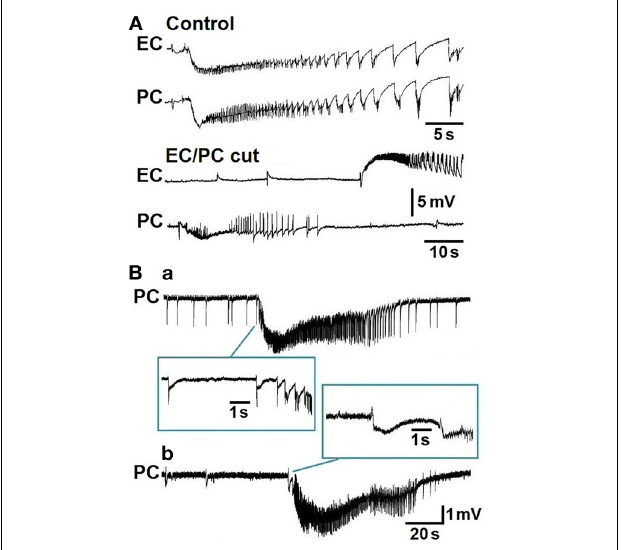
FIGURE 3 | (A) Ictal discharges occur synchronously in entorhinal (EC) and perirhinal (PC) cortices in an in vitro brain slice treated with 4-aminopyridine (Control panel). Note that cutting the connections between entorhinal and perirhinal areas causes the occurrence of independent ictal activity in these two structures (EC/PC cut panel). (B) Two types of ictal discharge initiation can be recorded from the perirhinal cortex during bath application of 4-aminopyridine. Note that the ictal discharge shown in (a) is characterized by acceleration of the interictal events preceding its onset while that in (b) is characterized by a “slow” interictal